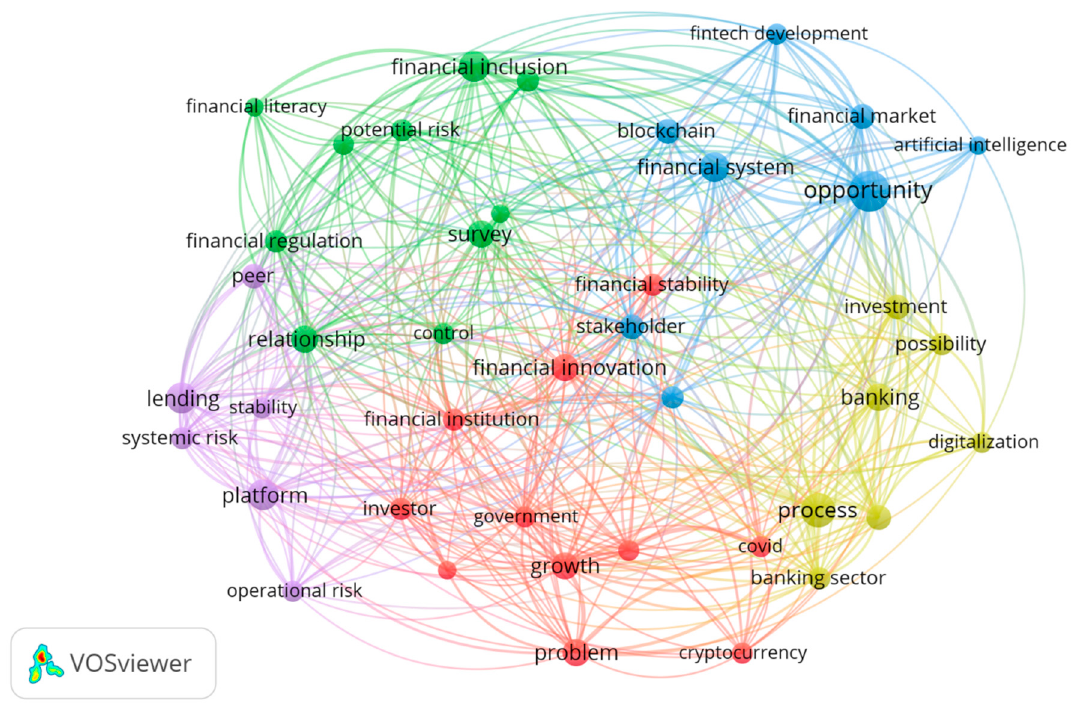
Figure 4. Co-occurrence of Terms (‘Authors’ compilation through VOSviewer).